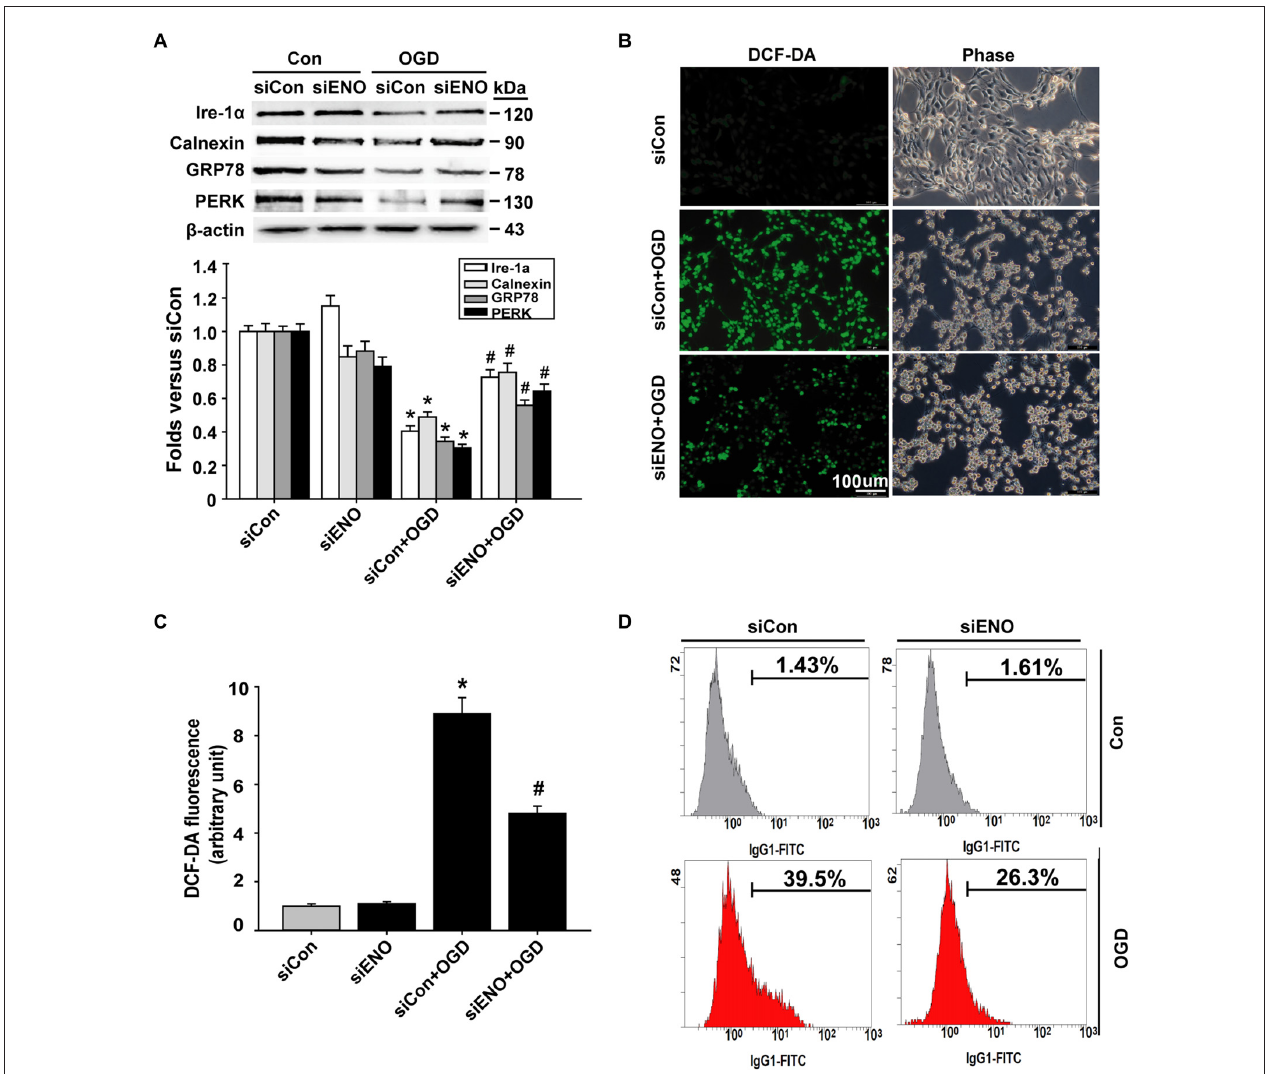
FIGURE 5 | Knockdown of ENOPH1 inhibits OGD-induced oxidative stress in bEND3 cells. Down-regulation of ENOPH1 on OGD induced Endoplasmic reticulum (ER) stress signaling were determined by western blot. (A) Upper panel: representative immunoblots showing the changes of Ire-1a, calnexin, GRP78 and PERK protein bands in bEND3 cells after 6 h OGD treatment, with or without siENOPH1 transfection; bottom panel: quantitative data showed that OGD significantly decreased the mentioned ER stress chaperon protein level and knockdown of ENOPH1 inhibited this change. β -actin was used as a loading control. ∗ P < 0.05 vs. siCon; # P < 0.05 vs. siCon + OGD; n = 4. (B) bEND3 cells transfected with siENOPH1 or control were loaded with DCF-DA (10 µ M) to detect intracellular reactive oxygen species (ROS) production. Representative microscope pictures were shown (bar = 100 µ m). (C) Quantification data showed that OGD significantly increased ROS production and knockdown of ENOPH1 inhibited ROS increase. ∗ P < 0.05 vs. control; # P < 0.05 vs. OGD; n = 4. (D) Representative flow cytometry of cells transfected with or without siENOPH1 after 6 h OGD treatment. Cells were stained with DCF-DA solution and then the levels of intracellular ROS were analyzed by flow cytometry; n =